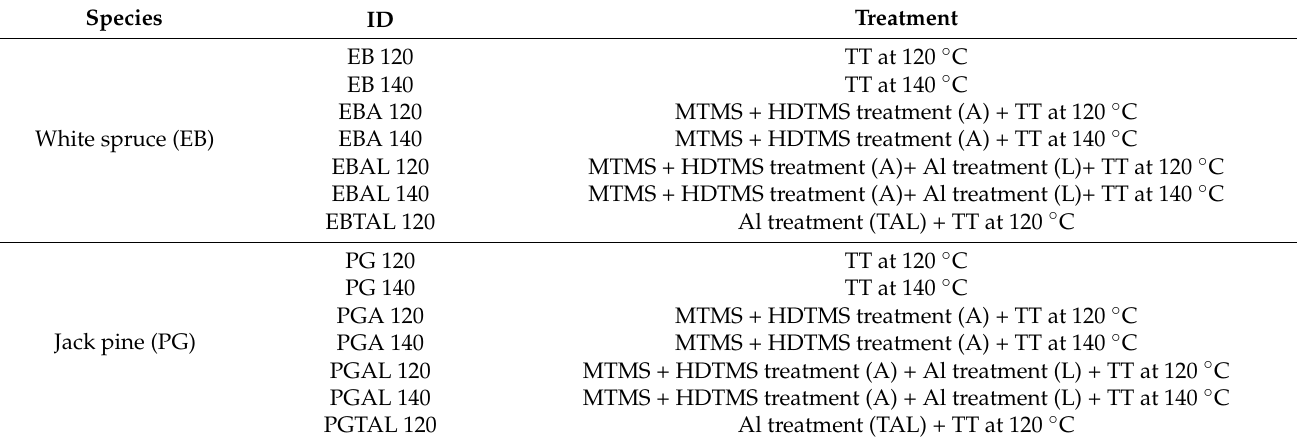
Table 2. Identification and description of the different treatment performed on white spruce and jack pine. Species ID Treatment